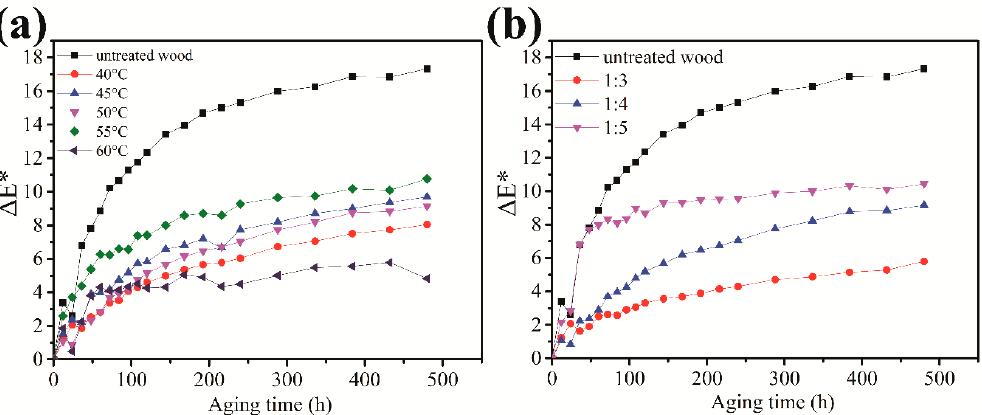
Figure 5. Variation tendency of Δ E* of the untreated wood and coating composite with sol coatings obtained under ( a ) different reaction temperatures (40 °C, 45 °C, 50 °C, 55 °C, 60 °C) ( b ) different ratio between Eu 3+ and ligands To further investigate the optical properties of the coating composite under sustained UV radiation (340 nm), the variations in the values of the emission peaks of Eu 3+ (614 nm) in the coating composites obtained at the most optional conditions with a ratio of 1:3 at 60 °C were evaluated. As shown in Figure 6, it can be seen that, after ultraviolet radiation, the fluorescence of wood is enhanced, which is perhaps due to the fact that, after a long period of radiation exposure, the silane undergoes further hydrolysis and condensation reactions, leading to the formation of an Si–O network structure, which will increase the rigidity of the ligand and reduce the energy loss by non-radiative deactivation [33]. On the contrary, the condensation reaction of organic–inorganic hybrid coatings change the coordination environment of Eu 3+ , which could be reflected by the ratio of 5 D 0 → 7 F 2 (614 nm) transition to 5 D 0 → 7 F 1 (590 nm) transition [34–36]. The larger ratio of 5 D 0 → 7 F 2 transition to 5 D 0 → 7 F 1 means that the chemical environment symmetry around the Eu 3+ ion is de- creased [37,38]. From Table 2, it can be seen that, after 14 days of radiation, the ratio in- creased from 1.40 to 1.74, then decreased to 1.68, which may be attributed to the fact that, initially, the silane coating was cross-linked to form an Si–O network structure under ul- traviolet light radiation. However, the layer structure is destroyed during long-term radi- ation exposure, and the coordination environment of the rare earth ions is changed back to its original state, only with a higher symmetry. From Figure 6, it can be indicated that the coating composites we prepared have an excellent fluorescence stability, and can transfer UV light to red light under long-term radiation exposure in order to protect the surface of wood from intense radiation.